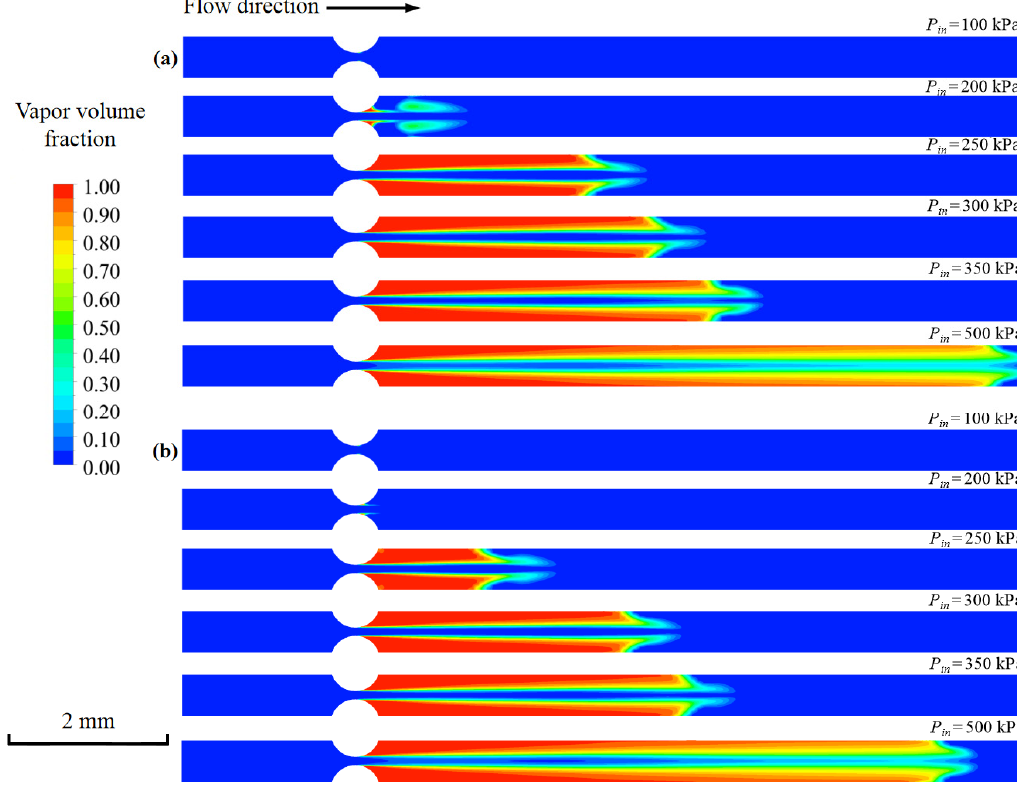
Figure 12. The vapor volume fraction with various inlet pressures: ( a ) DI water and ( b ) nano-fluid. Table 3. Mass flow rate under di ff erent outlet pressures.